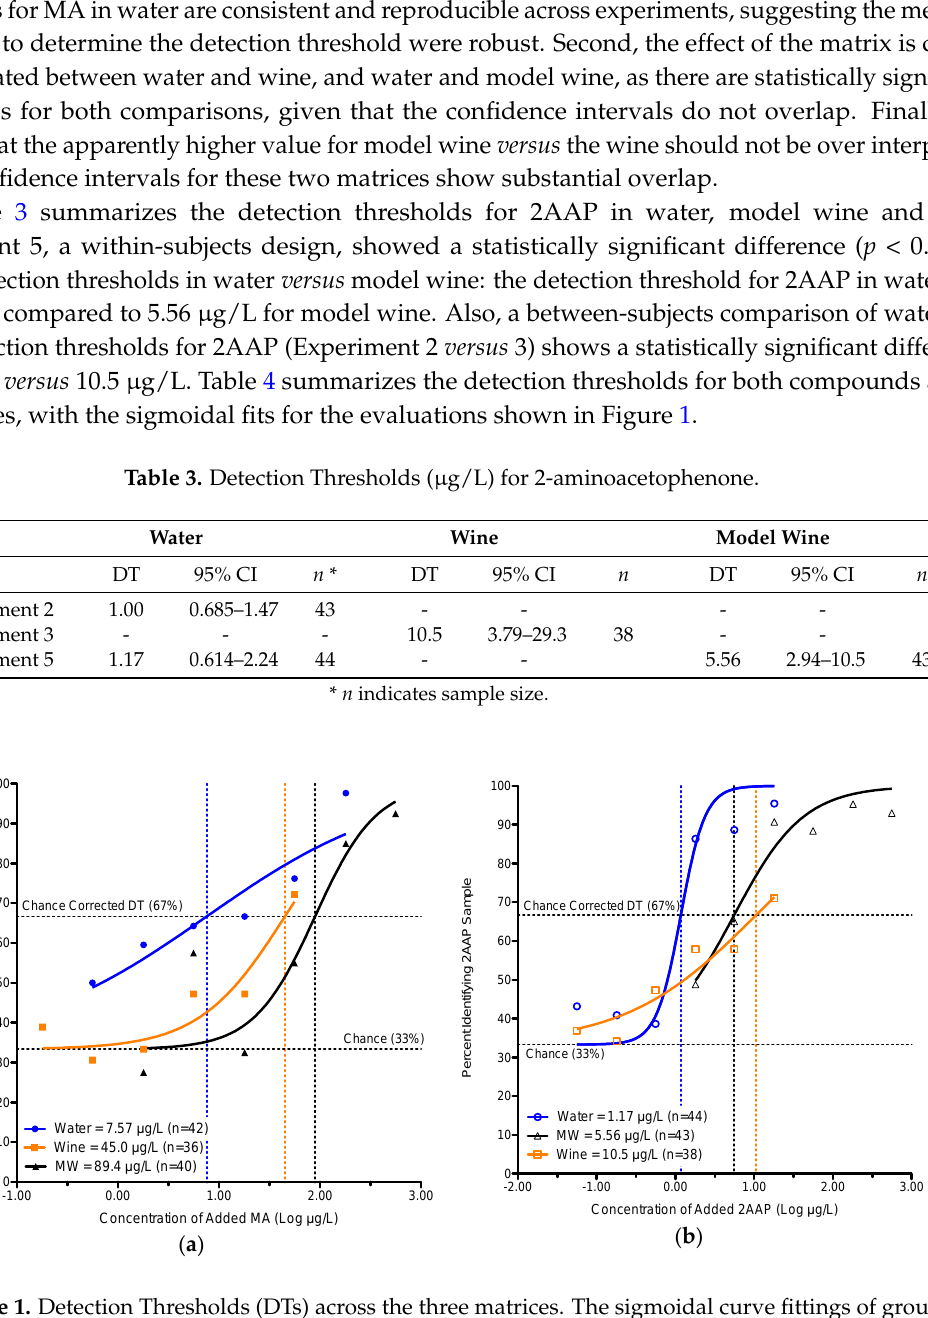
Table 2. Detection Thresholds (μg/L) for Methyl Anthranilate.